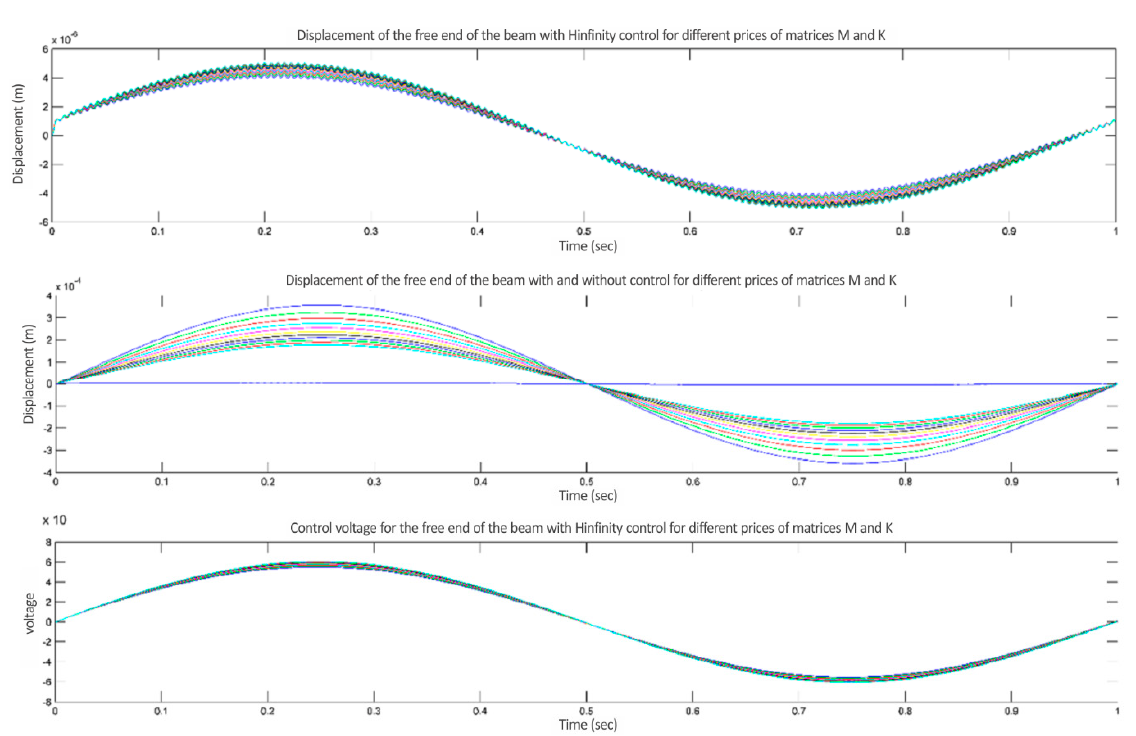
Figure 8. Results for matrices M (mass) and K (stiffness) at various costs, both with and without H inf control of the external sinusoidal inputs.